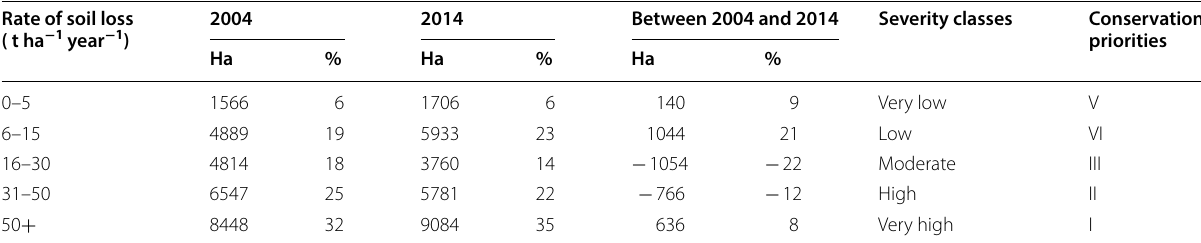
Table 6 Annual soil loss rate, severity classes and conservation priorities of Gelda catchment, Northwestern highlands of